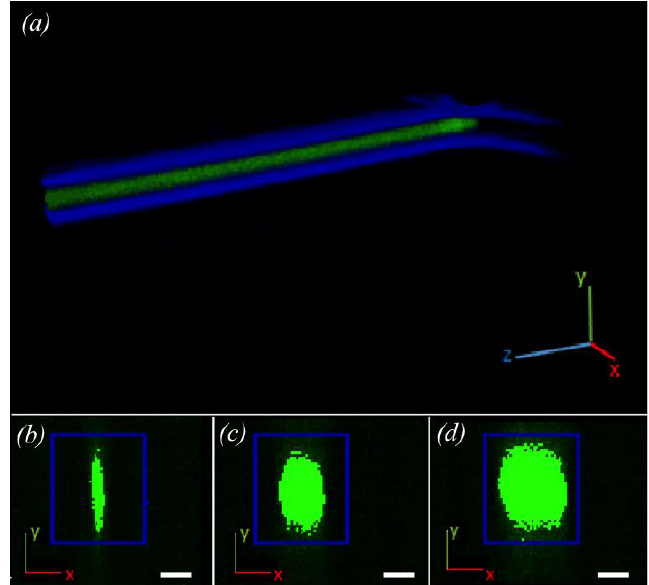
Figure 4. Top: ( a ) an example of 3D reconstruction with ImageJ software from the confocal microscope images. The blue feature corresponds to the walls of the microchannel where the coaxial inner flow ( Q int ) is formed, which is represented in green. Bottom: ( b – d ) There are three di ff erent examples of reconstructed cross sections ( x , y -plane) of the inner flow at di ff erent flow ratios (b: 5 mL / min, c: 30 mL / min, d: 75 mL / min). Scale bar: 50 µ